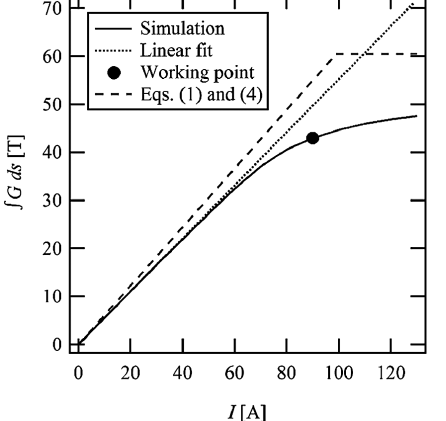
FIG. 12. Excitation curve of the high gradient quadrupole. The results obtained from the analytic model [Eqs. (1) and (4)] are given assuming a 493 mm magnetic